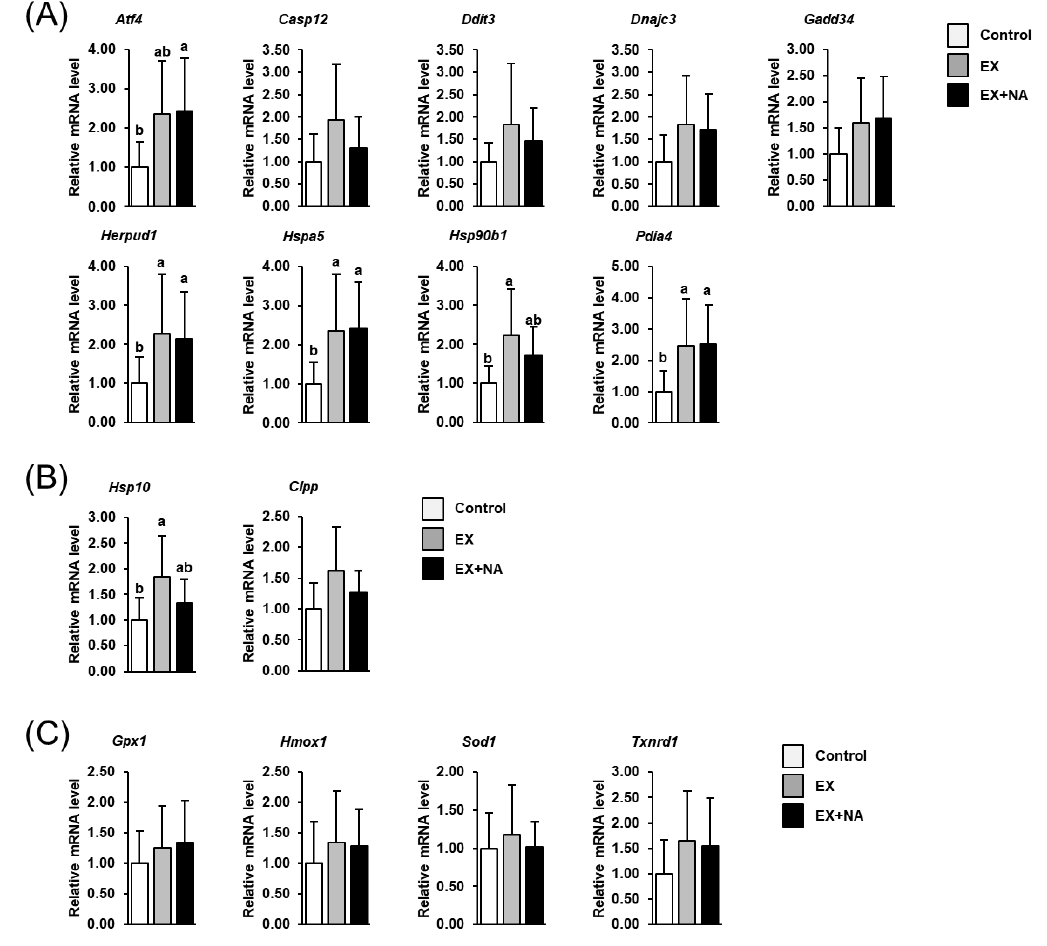
Figure 7. Relative mRNA levels of UPR ER target genes ( A , activating transcription factor 4 ( Atf4 ); caspase 12 ( Casp12 ); DNA damage inducible transcript 3 ( Ddit3 ); DnaJ heat shock protein family (Hsp40) member C3 ( Dnajc3 ); growth arrest and DNA-damage-inducible 34 ( Gadd34 ); homocysteine inducible ER protein with ubiquitin like domain 1 ( Herpud1 ); heat shock protein family A (Hsp70) member 5 ( Hspa5 ); heat shock protein 90 beta family member 1 ( Hsp90b1 ); protein disulfide isomerase family A member 4 ( Pdia4 )), UPR MT target genes ( B , heat shock protein family E (Hsp10) member 1 ( Hsp10 ); caseinolytic mitochondrial matrix peptidase proteolytic subunit ( Clpp )) and cytoprotective genes involved in the antioxidant response ( C , glutathione peroxidase 1 ( Gpx1 ); heme oxygenase 1 ( Hmox1 ); superoxide dismutase 1 ( Sod1 ); thioredoxin reductase 1 ( Txnrd1 )) in gastrocnemius muscle of sedentary mice fed an NA adequate diet (Control) and mice subjected to regular endurance exercise fed either an NA adequate diet (EX) or a high NA diet (EX + NA) for 6 weeks. Bars represent means ± SD for n = 10 animals per group. Relative mRNA levels are expressed as fold of Control (= 1.0). Bars without a common lowercase letter (a, b) differ, P < 0.05. 3. Discussion The main finding of the present study is that administration of a high NA diet to mice subjected to a six week endurance exercise program improves endurance exercise performance. The NA dose ingested from the high NA diet caused a 7- to 10-fold elevation in the plasma NAM concentration in mice of the EX + NA group compared to mice of the other groups. The NA dose administered to the mice (approximately 95 mg/kg body weight) is comparable to that used in humans, in which NA doses of 2–6 g/day equivalent to 30–90 mg/kg body weight for an individual weighing 70 kg are applied to induce serum lipid-lowering effects. In agreement with other studies, NA and NUA could not be detected even in plasma of mice fed the high NA diet [3,10]. This is attributed to the fact